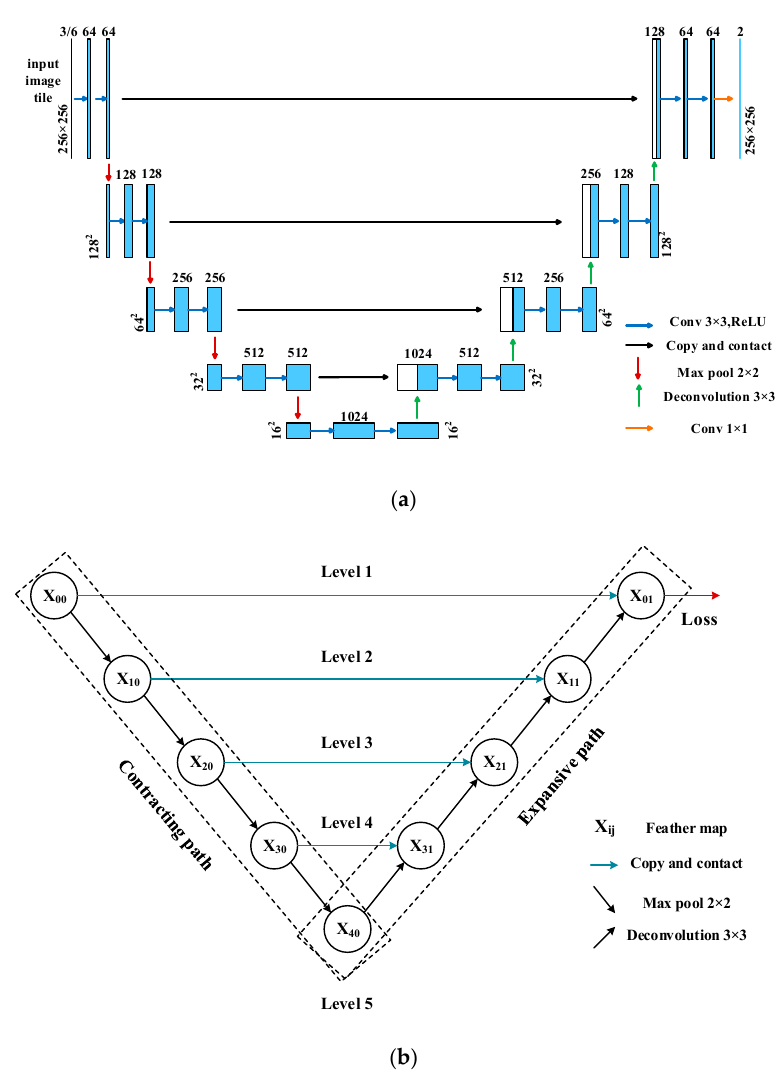
Figure 3. ( a ) U-Net architecture [28] and ( b ) Simplified U-Net topology diagram from ( a ).